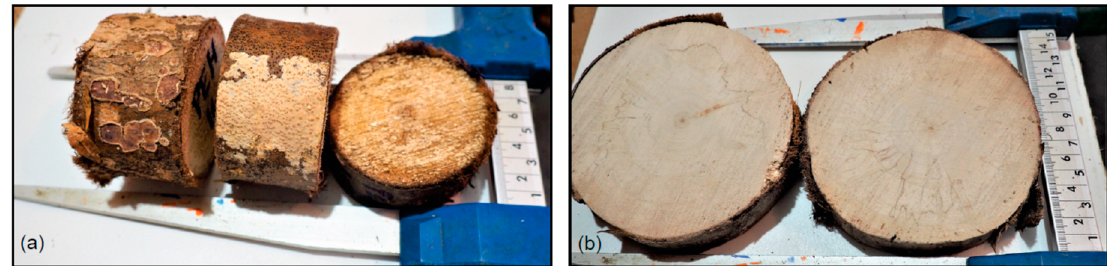
Figure 8. ( a ) Fruiting bodies; and ( b ) mycelium observed following fungal colonization of hybrid poplar logs (110 cm length) after one year of outdoor seasoning.